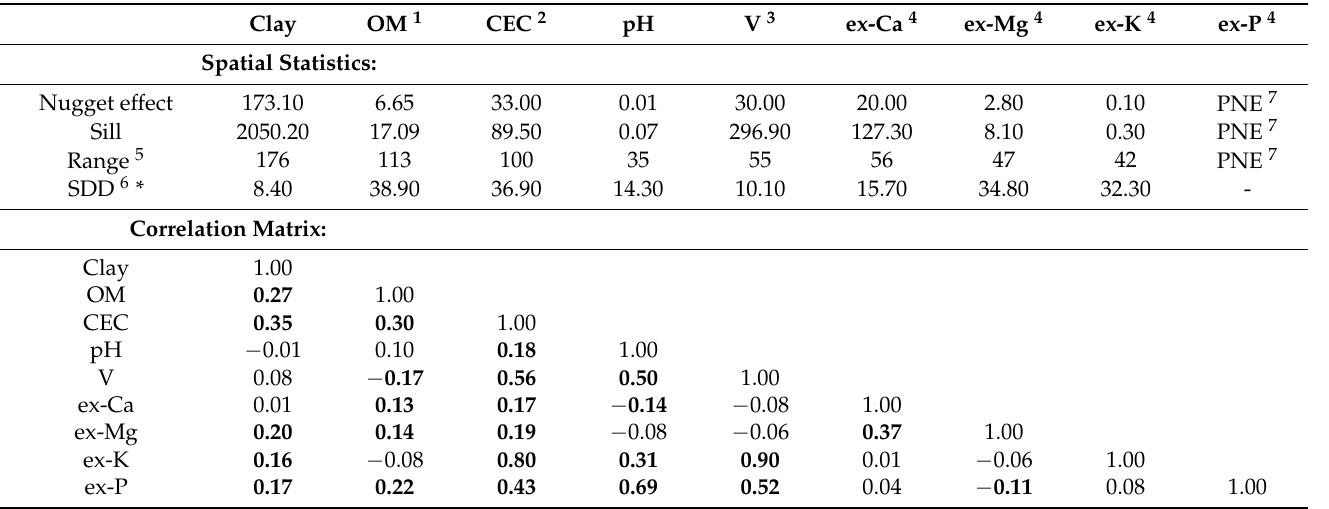
expressed in meters; 6 spatial dependence degree; 7 pure nugget effect. Bold values indicate a significant correlation ( p value < 0.05); * SDD values can be interpreted as strong spatial dependence when less than 25%, moderate spatial dependence when between 25 and 75%, and weak spatial dependence when greater than 75%